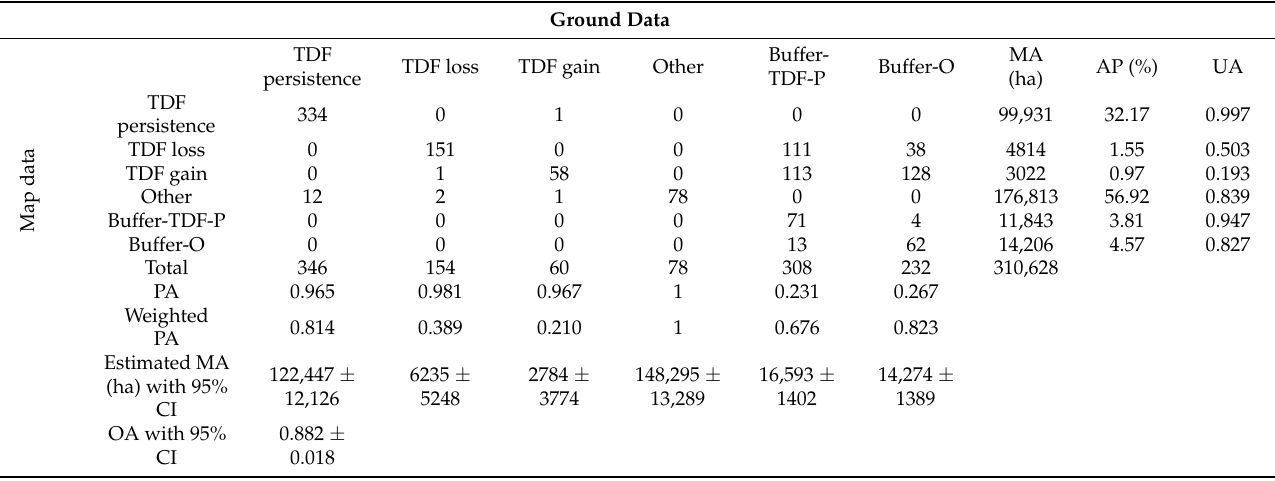
Table 3. Error matrix with sample points. OA: overall accuracy; PA: producer’s accuracy; UA: user’s accuracy; CI: confidence interval; MA: map area; AP: area proportion; Buffer-TDF-P: buffer in TDF persistence, Buffer-O: buffer in other.